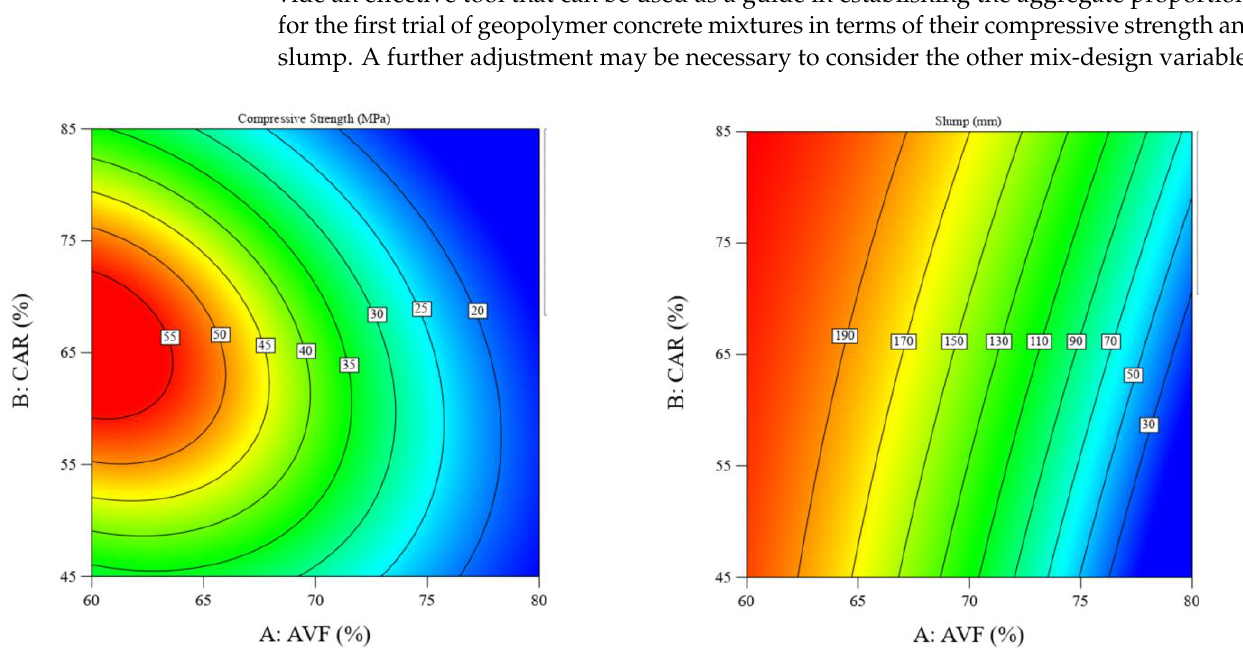
Figure 15. Contour graphs of compressive strength and slump at MAS = 16 mm and FFM = 2.8.